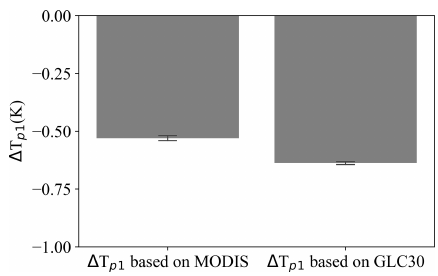
Figure A5. The mixed potential effects ( (cid:49)T p ) obtained based on MODIS land-cover data (MCD12Q1) and the land-cover distribution map 1 defined at the threshold of 50% GlobeLand30 at 1km resolution.